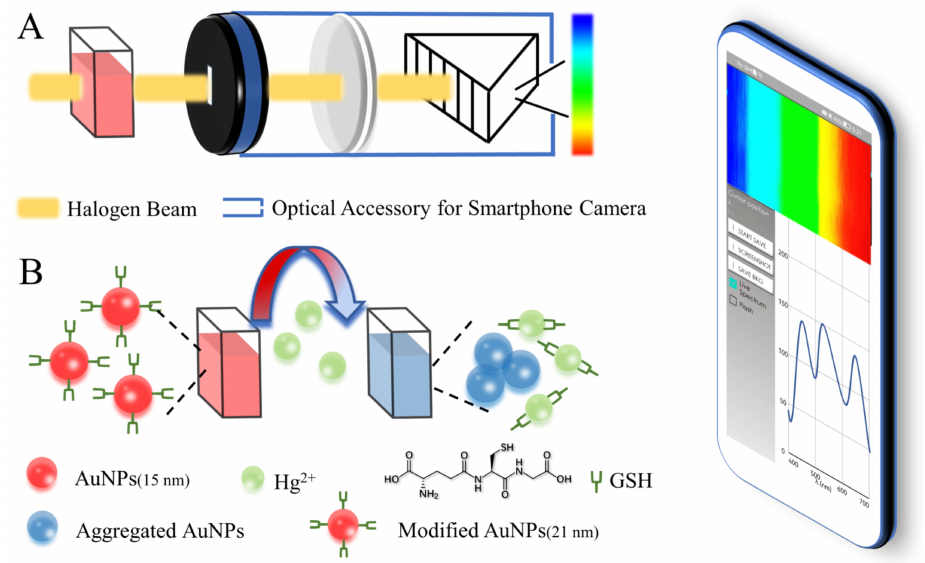
Figure 1. ( A ) Colorimetric biosensor system based on a smartphone; ( B ) schematic illustration of Hg 2+ detection based on